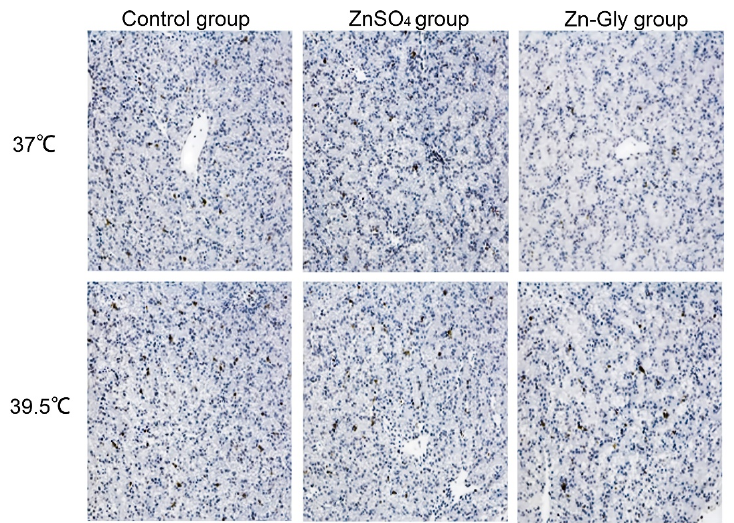
Figure 2. Effect of maternal zinc on liver apoptosis in embryos under heat stress (200×).